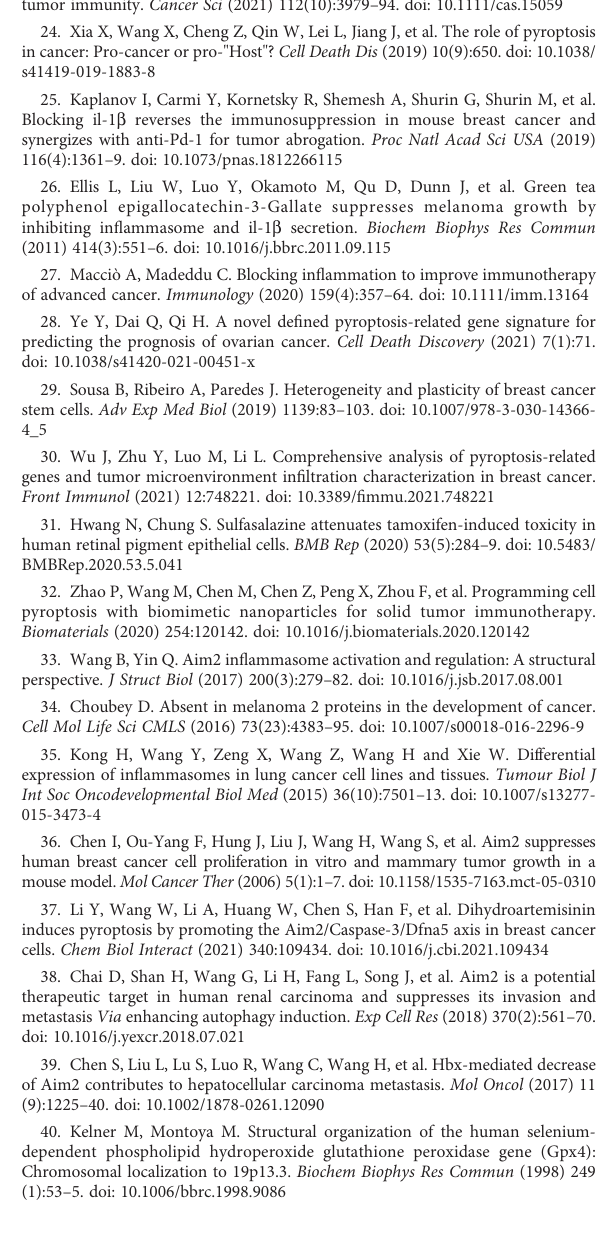
SUPPLEMENTARY FIGURE 4 The pyroptosis-associated signature as a potential predictor for the sensitivity of anti-cancer drugs. The respective IC50 value of chosen anti-cancer drugs (Paclitaxel, Vinorelbine, Tamoxifen, Lapatinib, Epirubicin, and Fulvestrant) in relation to the risk score, as shown by Pearson ’ s correlation analysis, appeared to associate with the pyroptosis- related signature (|Pearson ’ s correlation| > 0.25 and P<